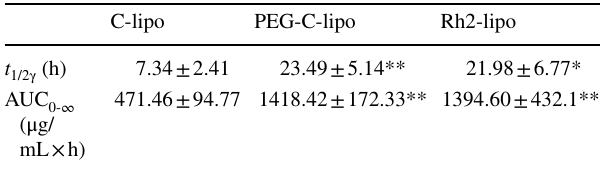
Table 2 PK parameters after liposomes administration (n = 3; mean ± SD)